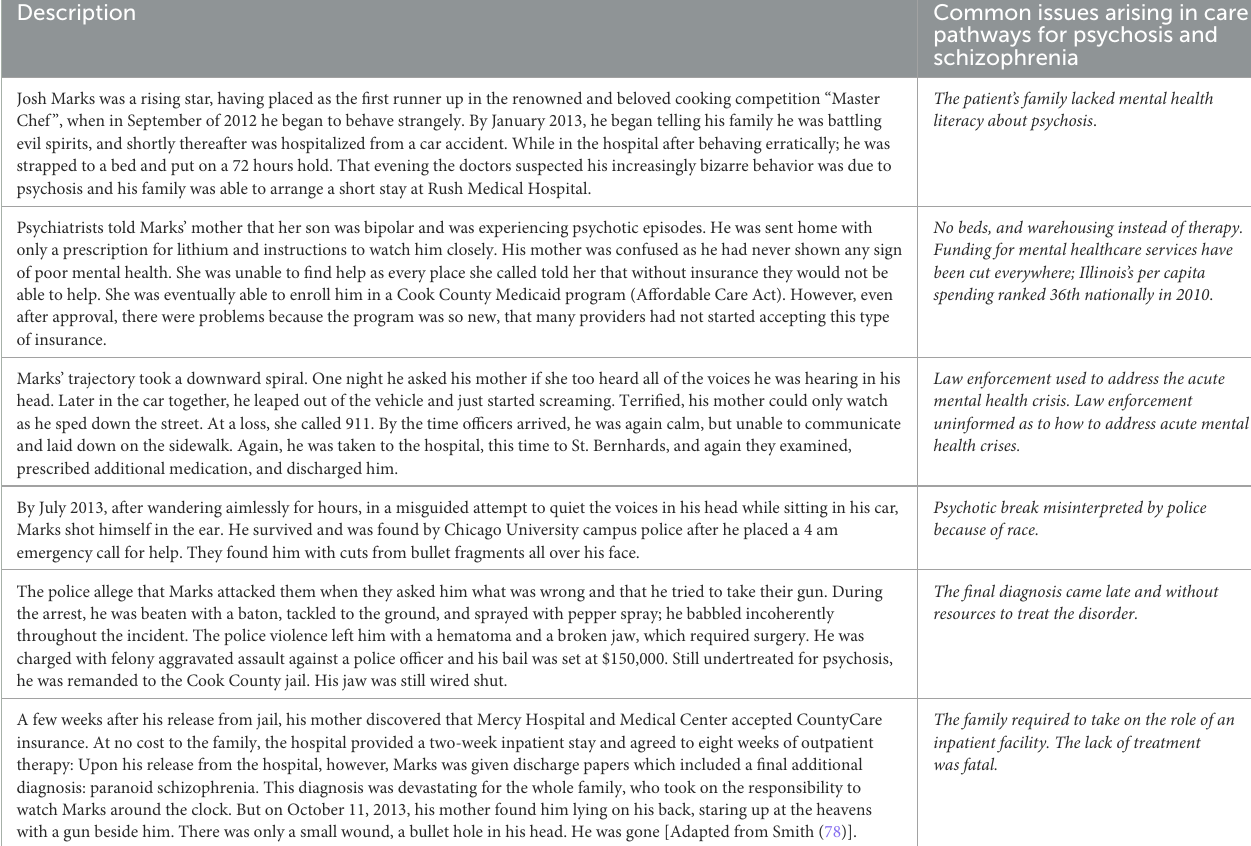
TABLE 3 Case study: The tragic suicide of a master chef rising star. Description Common issues arising in care